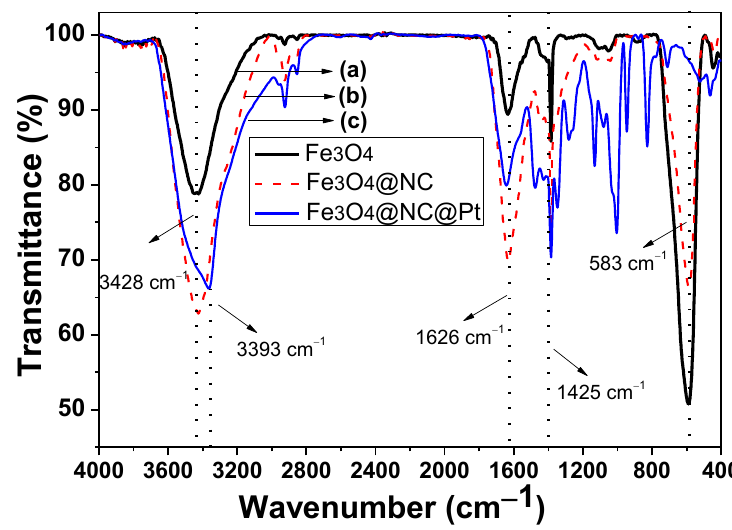
Figure 1. FT-IR spectra of ( a ) Fe 3 O 4 ; ( b ) Fe 3 O 4 @NC; ( c ) Fe 3 O 4 @NC@Pt. The catalyst composition and formulation were characterized by X-ray diffraction (XRD). In Figure 2a–c, the peaks at 2 θ values of 18.2 ◦ , 30.1 ◦ , 35.4 ◦ , 37.1 ◦ , 43.1 ◦ , 53.4 ◦ , 53.4 ◦ , 56.9 ◦ , and 62.5 ◦ are well in agreement with the pure Fe 3 O 4 (JCPDS 74-0748) [32,33]. In Figure 2c, the peaks at 2 θ values of 40.0 ◦ , 46.5 ◦ , and 67.8 ◦ are attributed to the Pt (JCPDS 01-1194) [14]. All XRD patterns have no other impurities peaks, the sharp and strong diffraction peaks also confirm the well crystallization of the products. Meanwhile, in Figure 2b,c, the broad peak at 2 θ = 21.6 ◦ is the characteristic reflection of amorphous nitrogen-doped carbon [34].